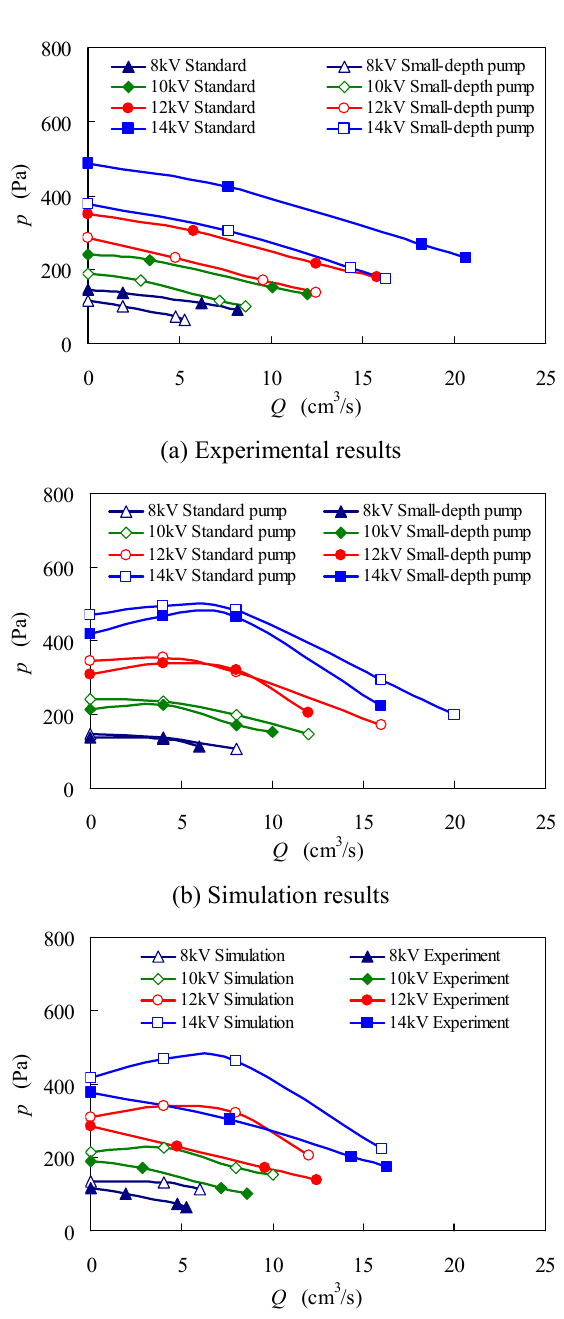
(c) Comparison of measured p-Q characteristic with simulated one of small-depth pump Fig.9 Effect of pump chamber depth on p-Q characteristic ( k =7.1×10 -9 C/(V ･ m 2 ), µ for = 60 µ i iw